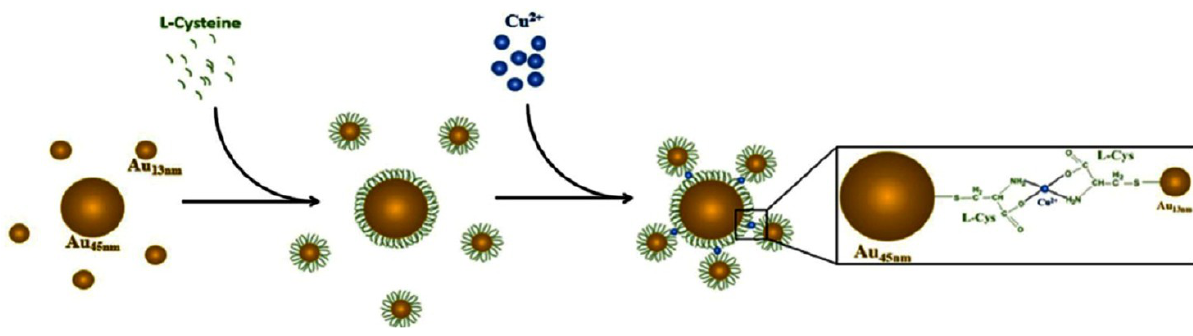
Figure 3. Schematic representation of the protocol used to synthesis Cu 2+ mediated core-satellite structure by using gold nanoparticles (GNPs) of two different sizes. Reprinted from reference [82] Copyright 2013, with permission from